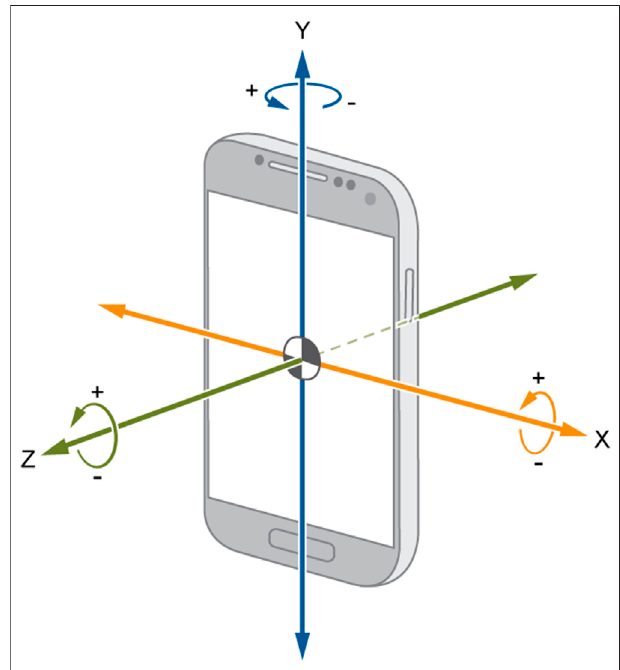
FIGURE 1 | Accelerometer and